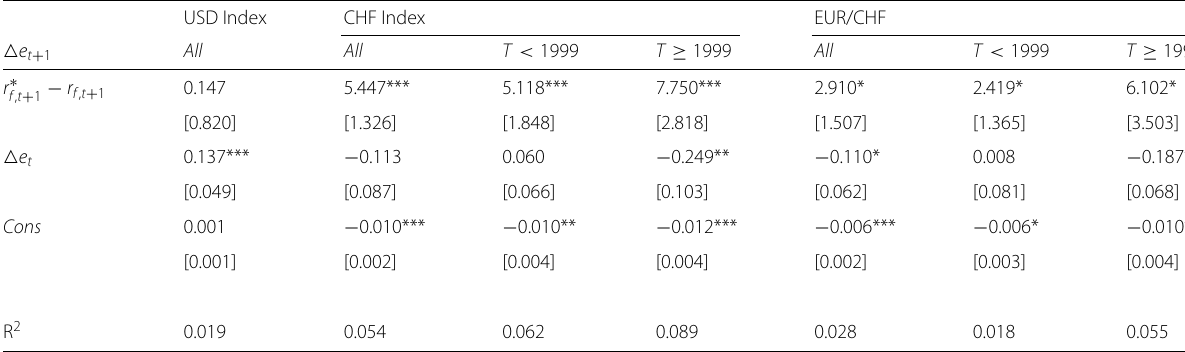
Table 4 Zero-stage regression: exchange rate